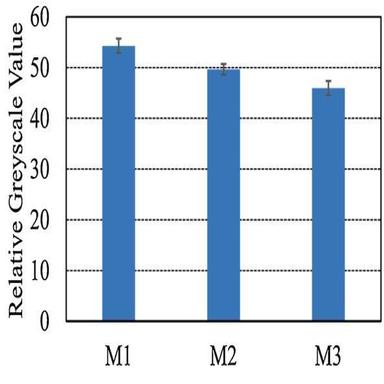
Relative greyscale at the center of M1 to M3 for the bar sample indicating the concentration of the magnetic particles.